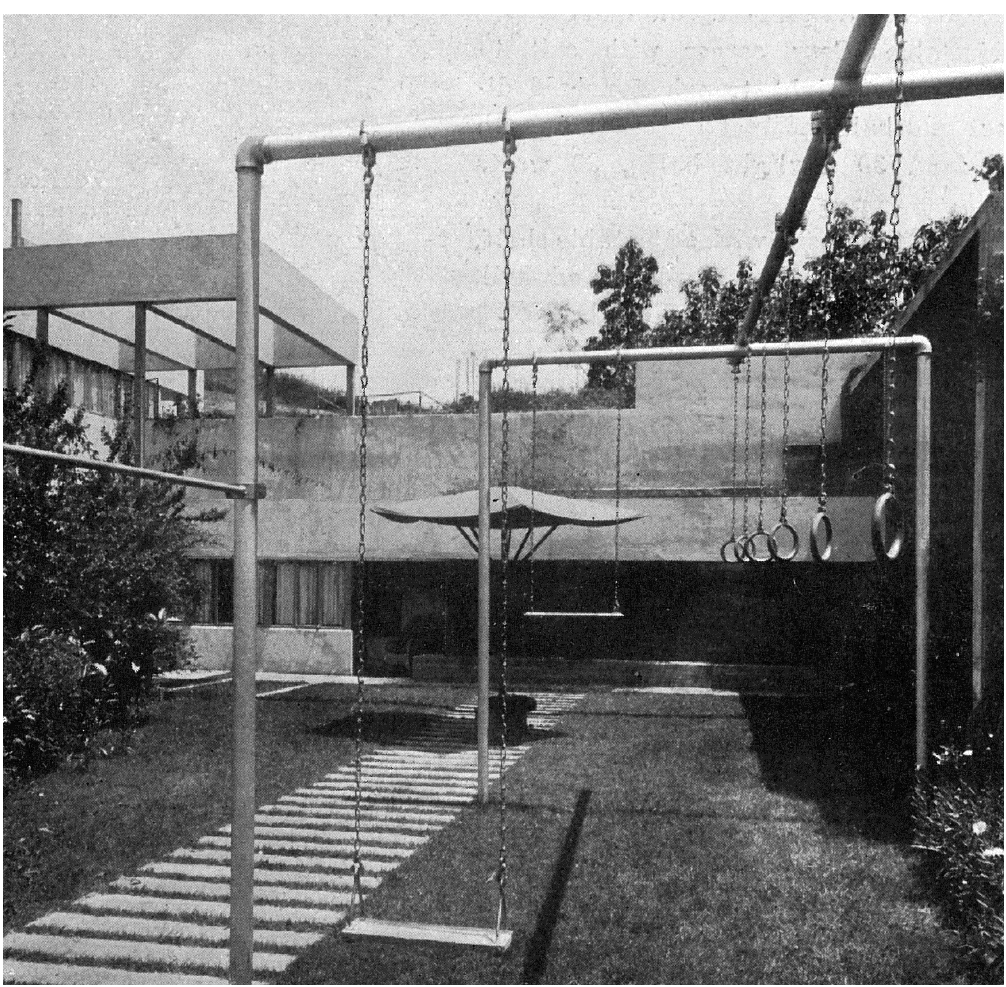
Figure 1. Richard Neutra, Lovell Health House, Los Angeles, 1927–1929. Exercise equipment. (Photo